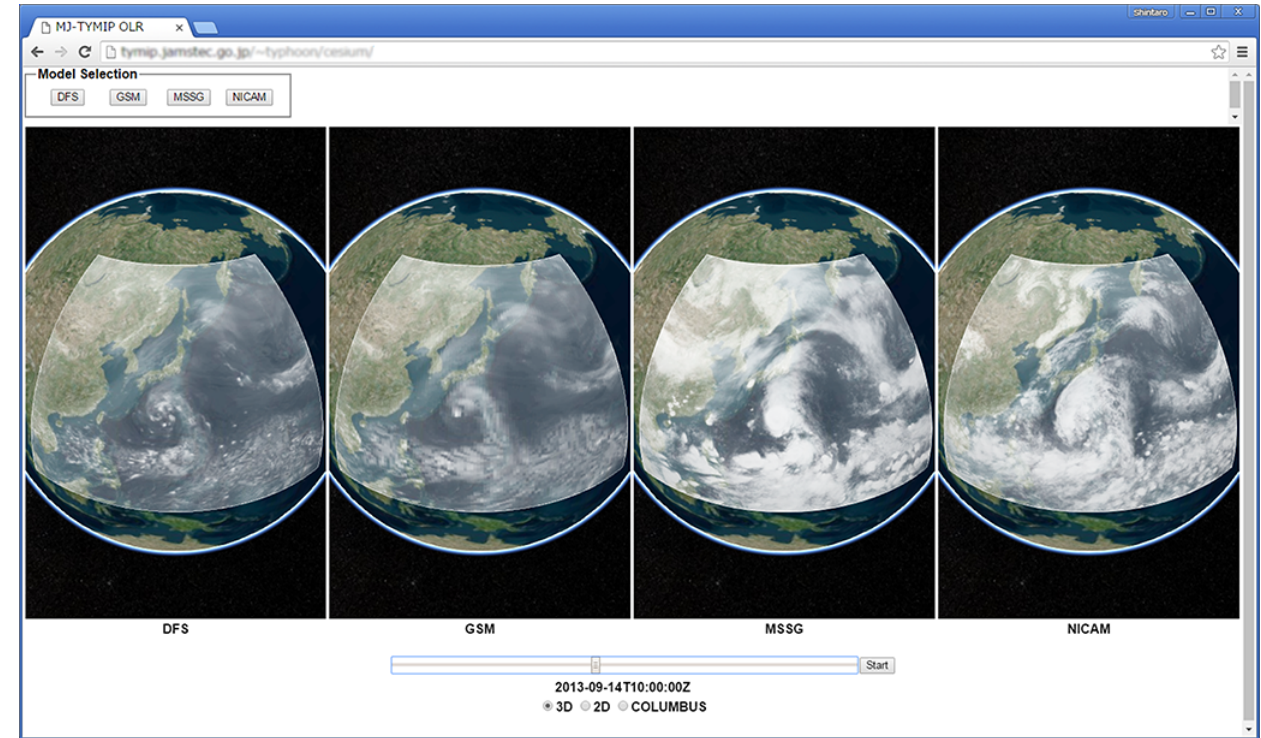
Figure 2. Screen capture of the web application: outgoing longwave radiation at 14 September 2013, 10:00:00UTC, simulated in experiments initialized at 12 September 2013,